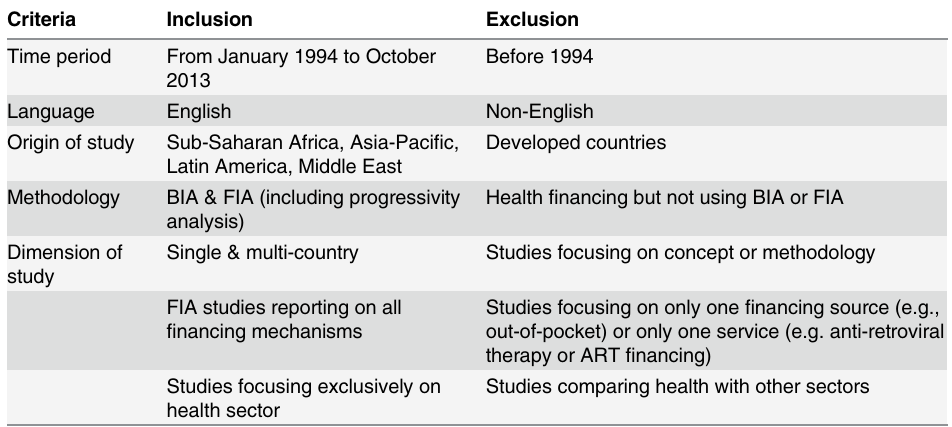
Table 1. Inclusion and exclusion